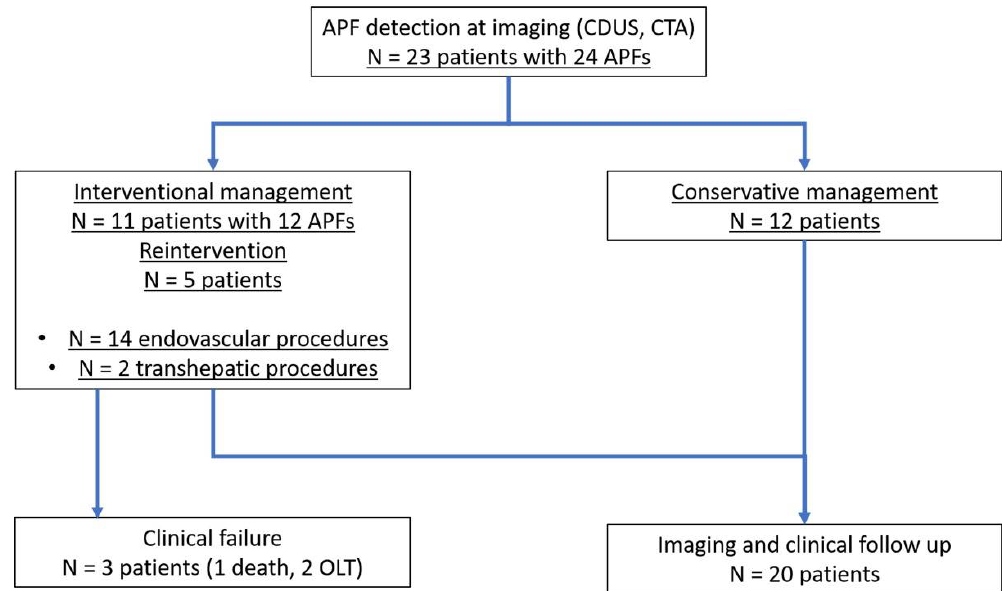
Figure 3. Algorithm of the study design and patient management. APF, arterioportal fistula; CDUS, color Doppler ultrasound; CTA, computed tomography angiography; OLT, orthotopic liver transplantation. The majority of patients (20/23, 87%) were OLT recipients, and 16/20 presented iatro- genic arterioportal shunts (15 type 1; 1 type 2): etiology was most likely liver biopsy in 13